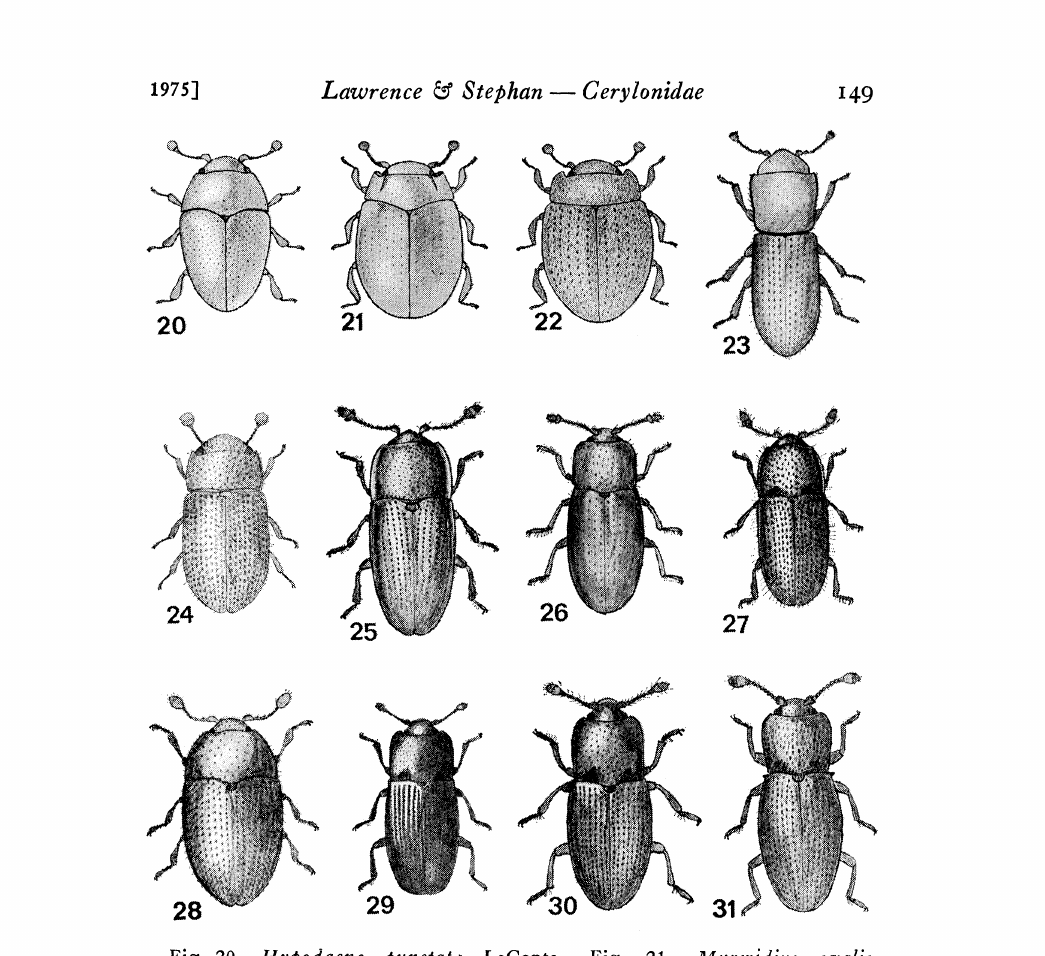
Fig. 20. Hypodacne lunctata LeConte. Fig. 21. Murmidius o.valis (Beck). Fig. 22. Mychocerus delressus LeConte. Fig. 23. Anommatus duodecimstriatus (Miller). Fig. 24. Ostomopsis neotrolicalis, n. sp. Fig. 25. Philothermus glabriculus LeConte. Fig. 26. P. occidentalis, n. sp. Fig. 27. P. #uberulus Schwarz. Fig. 28, La]ethus discretus Casey. Fig. 29. Cerylon distans, n. sp. Fig. 30. G. unicolor (Ziegler). Fig. 31. C. cali[onicum Casey. [Not drawn to same